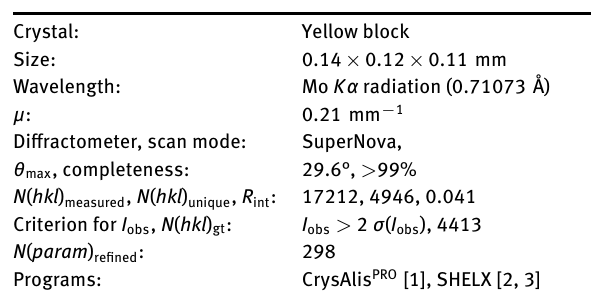
Table 1: Data collection and handling.